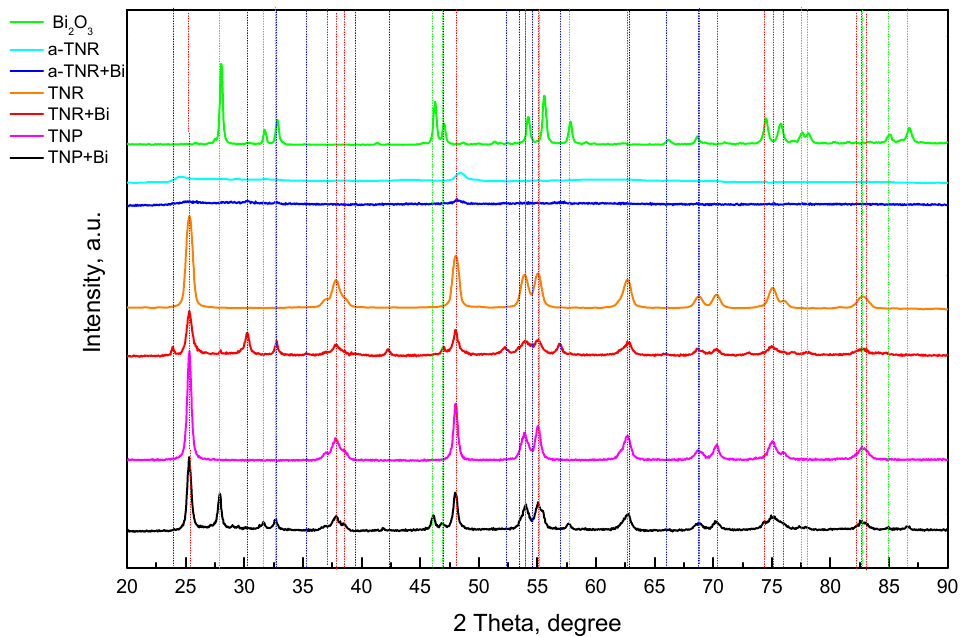
Figure 4. X-ray powder diffraction (XRD) patterns of the prepared materials (green vertical lines belong to tetragonal β -Bi 2 O 3 (JCPDS 00-027-0050), blue vertical lines to (BiO) 2 CO 3 (JCPDS 00-025-1464) and red vertical lines to anatase TiO 2 (JCPDS 00-021-1272).